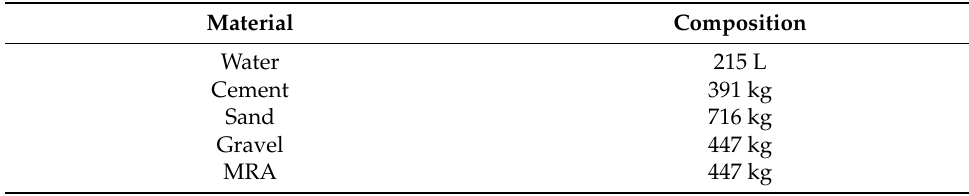
Table 1. Recycled concrete composition per cubic metre.